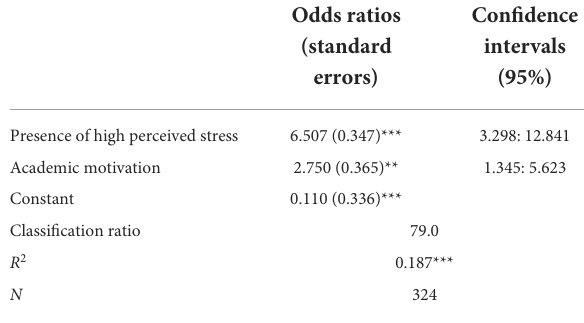
TABLE 3 Multiple binary logistic regression of the presence of anxiety symptoms.